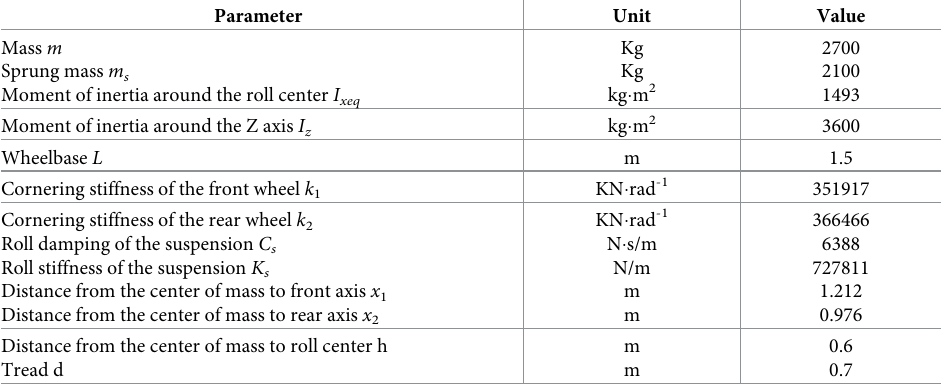
Table 1. Tractor parameters.